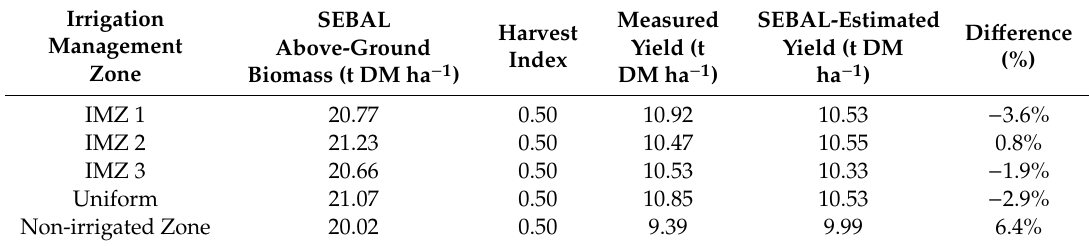
Table 2. Irrigation supplied during the growing season for all the management zones and the uniform